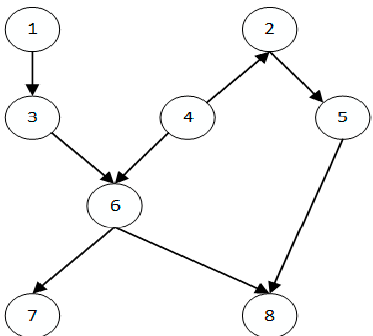
Figure 4. Standard ASIA.